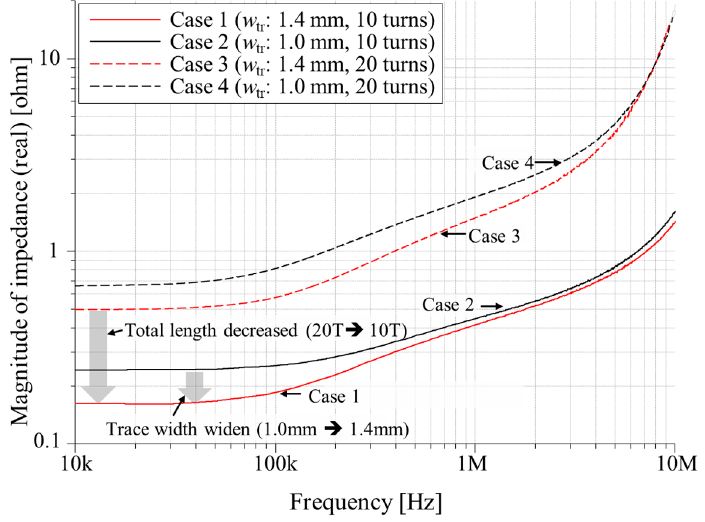
Figure 4. Simulated results of various coil trace designs. The outermost size of the designed coil was fixed at 27 mm × 27 mm.